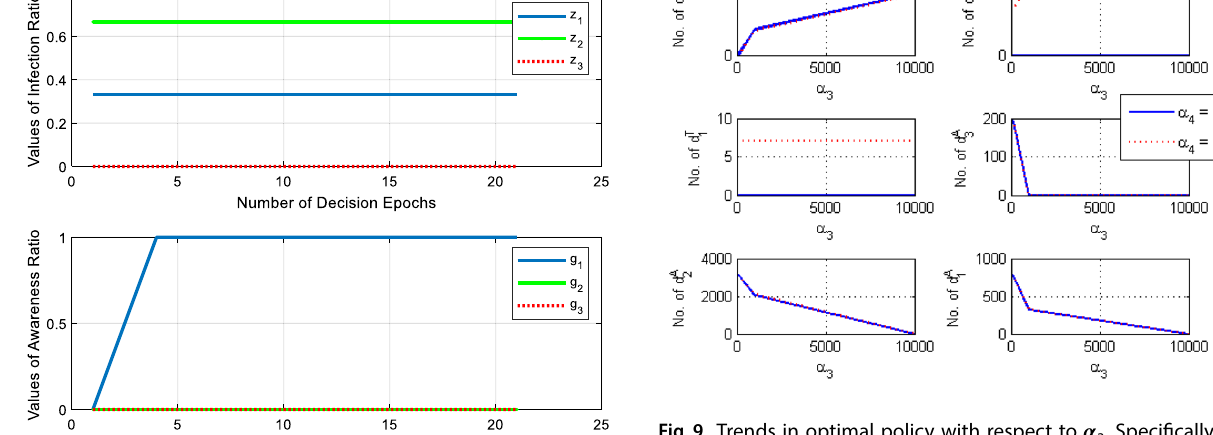
Fig. 9 Trends in optimal policy with respect to 𝜶 3 . Specifically, the frequency of each decision, e.g., no operation ( d 0 ), treatment cam- paign in network 1 ( d T 1 ), awareness campaign in network 2 ( d A 2 ) etc. is plotted against the ranges of the parameter ( 𝜶 3 ) values. Further- more, the blue graphs correspond to the value 𝜶 4 = 10 4 and the doted red graphs correspond to 𝜶 4 =